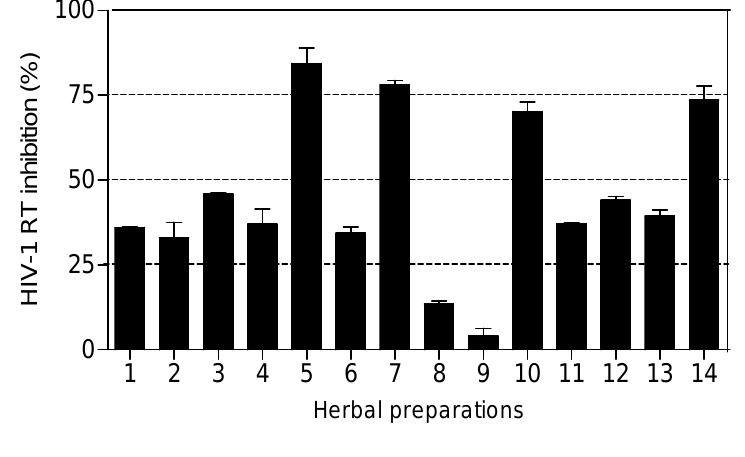
Figure 3. Percentage inhibition of HIV-1 RT by commercial herbal preparations (2.5 mg/mL). Herbal preparations with inhibitory activity above 70% were considered to be highly active. Percentage inhibition by positive controls: Combivir ® (0.5 mg/mL) and Kaletra ® (0.5 mg/mL) were 79.80 ± 0.12 and 62.50 ± 0.31